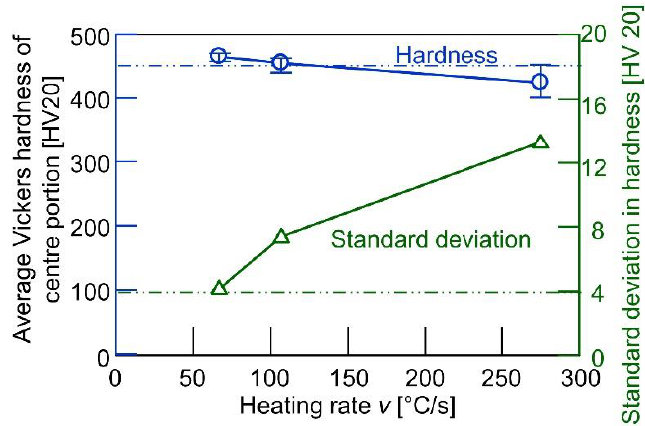
Figure 13. E ff ect of heating rate on Vickers hardness and standard deviation for t = 0 s.